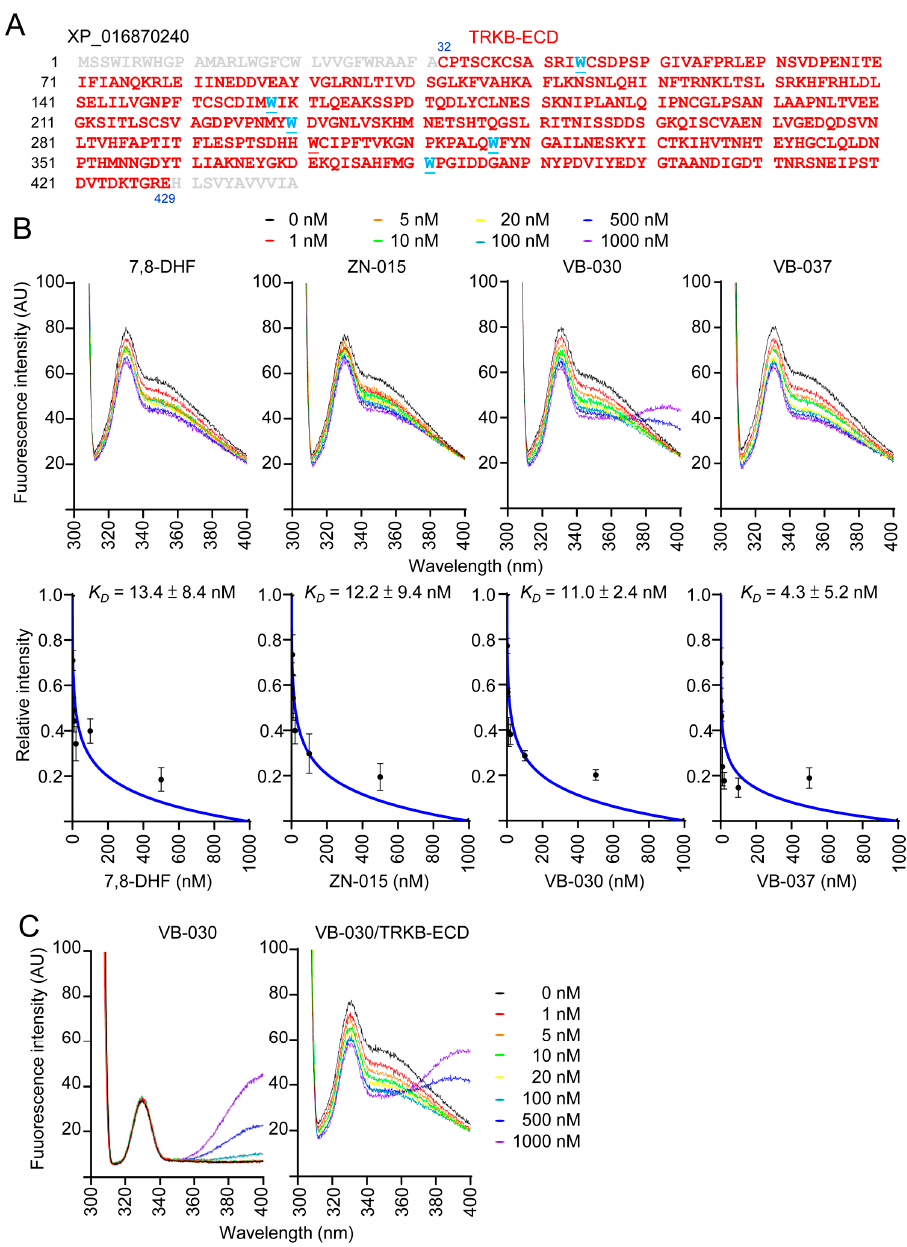
Figure 7. Binding assay of ZN/VB compounds to the extracellular domain of the TRKB. ( A ) Amino acid sequences of TRKB-ECD (marked in red, C 32 -E 429 , XP_016870240), with tryptophan (W) under- lined and marked in blue. ( B ) Top: Tryptophan fluorescence of TRKB-ECD recombinant protein titrated with 7,8-DHF, ZN-015, VB-030 and VB-037 (0–1000 nM). The tryptophan fluorescence of TRKB-ECD excited at 295 nm showed decreased intensity after titrating with increasing concentra- tions of test compounds. Bottom: The plot of normalized tryptophan intensities at emission 330 nm as a function of total added concentrations of test compounds. The dissociation constant ( K D ) be- tween test compounds and TRKB-ECD was calculated by fitting this plot with the equation de- scribed. ( C ) Fluorescence spectra of VB-030 (0–1000 nM) in the absence (left) or presence (right) of TRKB-ECD.